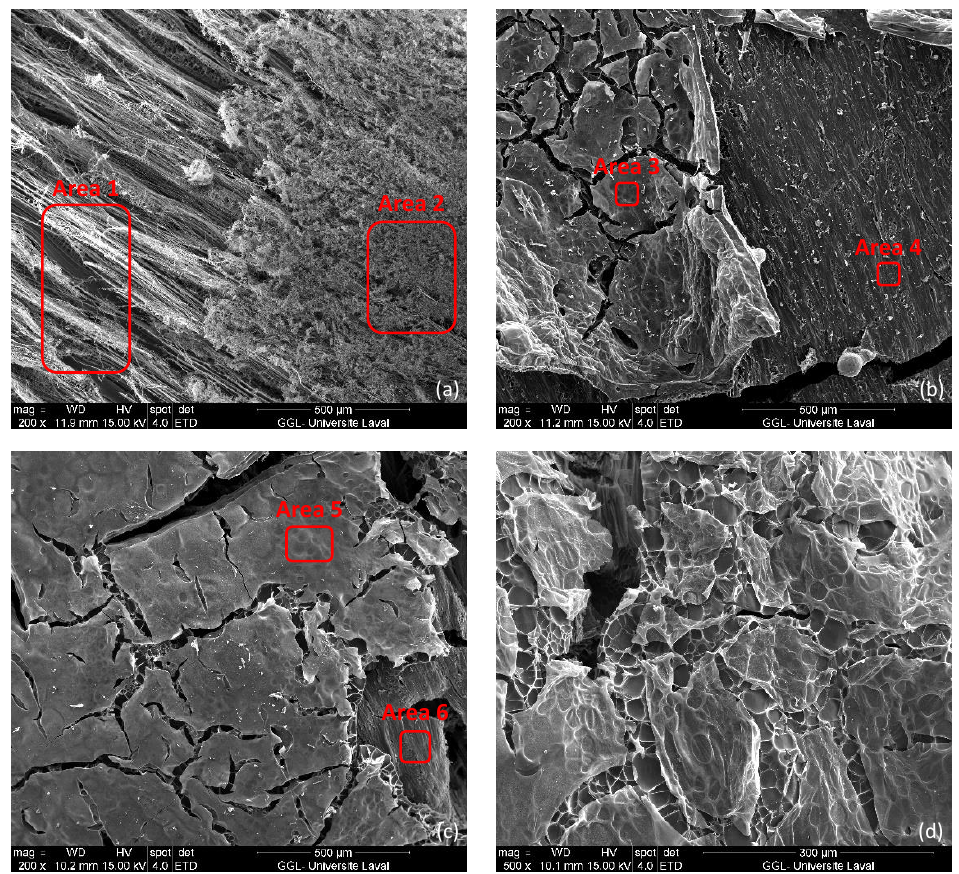
Figure 11. SEM images of cone calorimeter residues of F0 ( a ), F1 ( b ) and F2 ( c , d ). Table 5. Elemental composition analysis performed on different areas (identified on Figure 11) of the cone calorimeter residues.